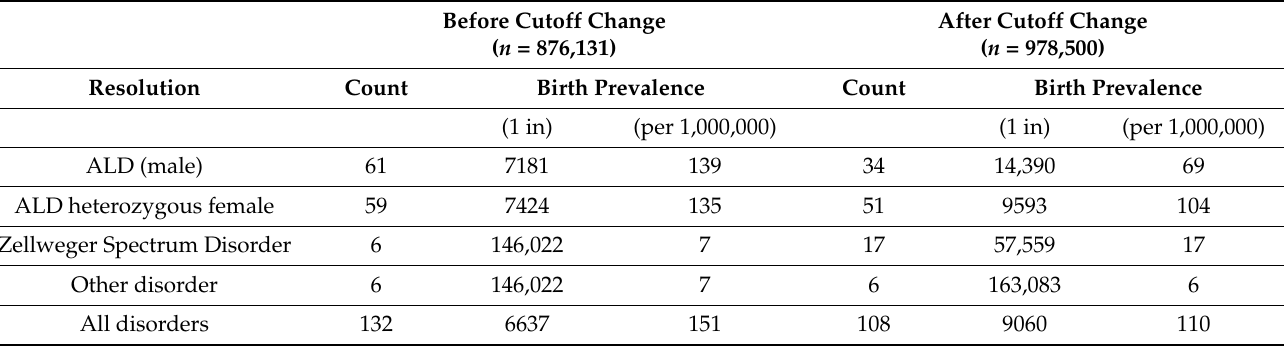
Table 2. Observed birth prevalence before and after the second-tier cutoff change on 12 December 2017. Before Cutoff Change